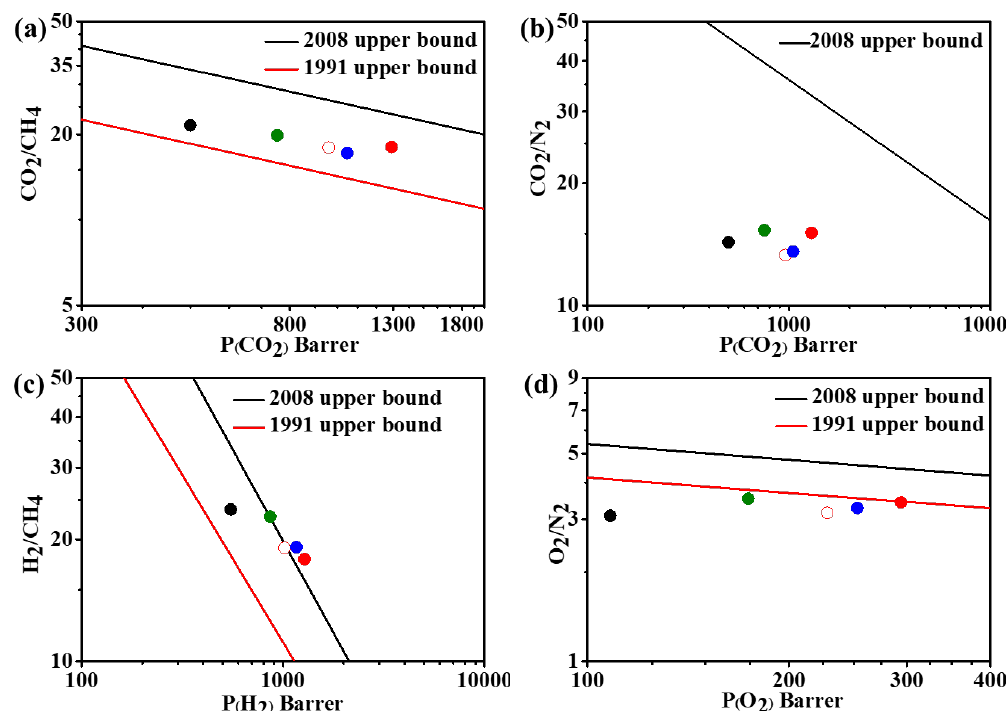
Figure 8. Robeson upper bound limit of ( a ) CO 2 /CH 4 separation; ( b ) CO 2 /N 2 separation; ( c ) H 2 /CH 4 separation; and ( d ) O 2 /N 2 separation. (●), ( ● ), ( ○ ), ( ● ), and ( ● ) are 6FDA-Durene, 5AP/6FDA-Durene, 10AP/6FDA-Durene, 5BP/6FDA-Durene, and 5TP/6FDA-Durene, respectively.